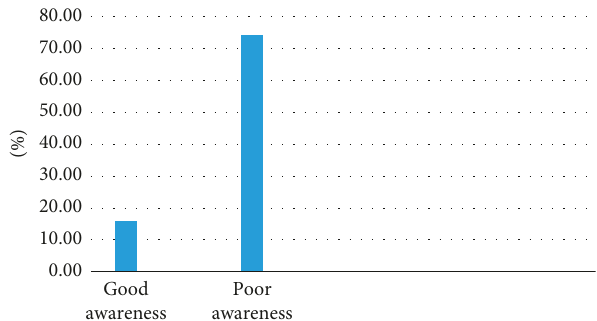
Figure 2: Distribution of women’s overall awareness on pre- conception folic acid supplementation in Adet, Gojjam, North- western Ethiopia, 2016 ( n �